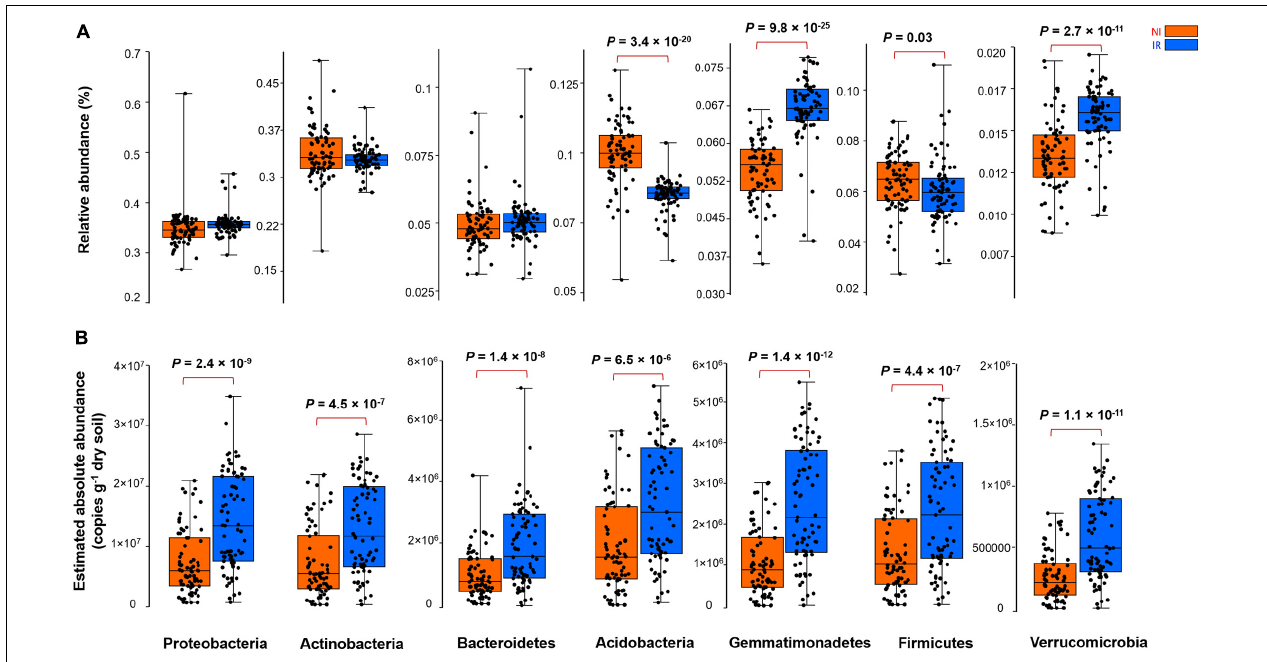
FIGURE 2 | The effect of soil history on (A) the relative and (B) estimated absolute abundance of different bacterial phyla associated with the rhizosphere of four wheat genotypes grown in Saskatchewan soils with a water stress history (NI) or with no history of water stress (IR) exposed to four levels of soil water content. Dots are values for individual observations, the horizontal lines in boxes are representative of the median, the upper and lower part of boxes indicating 75th and 25th quartiles, and whiskers on the boxes showing 1.5 × the interquartile range. ANOVA tests comparing the abundance of each phylum between IR and NI